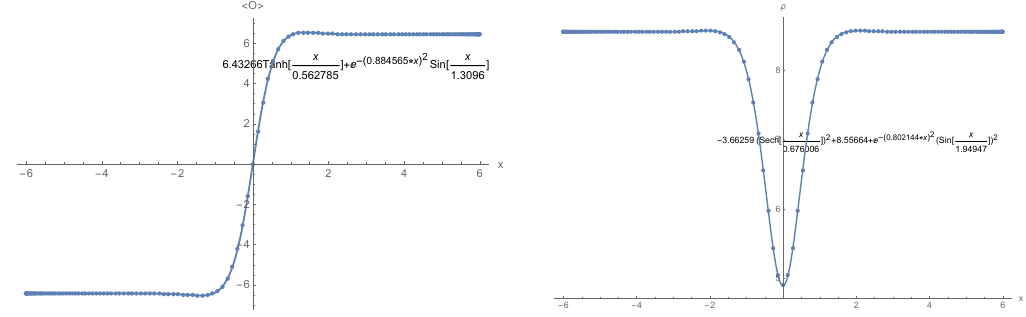
Figure 18 . The (cid:12)tting functions of order parameter (left panel) and charge density (right panel) at standard quantization with the chemical potential (cid:22) = 5 : 5.